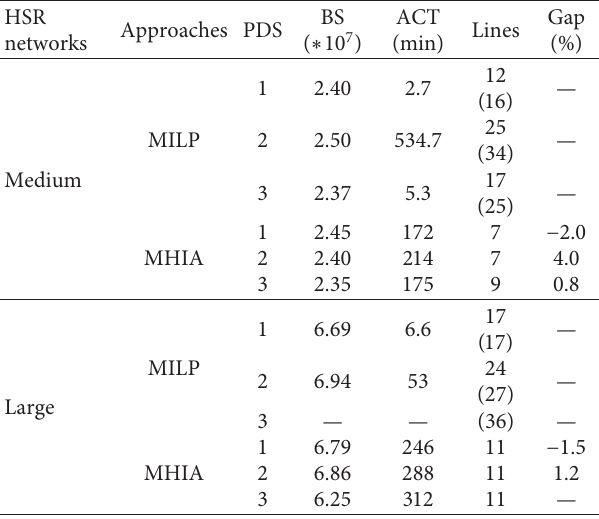
Table 12: Results of the given line pool for MILP on medium and large HSR networks. HSR Approaches networks